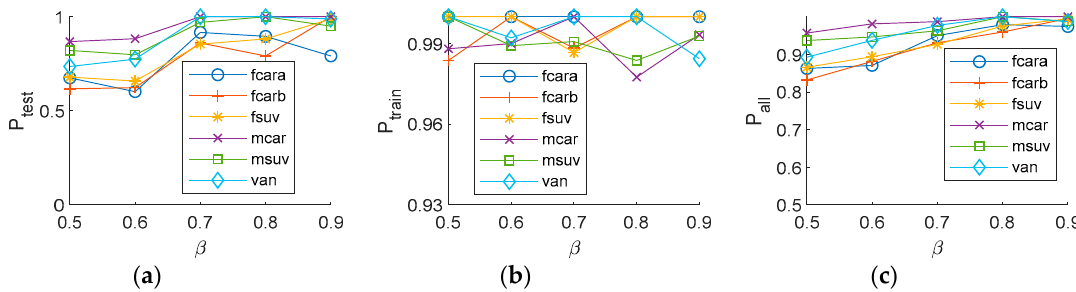
( c ) Figure 8. The curve of accuracy changing with training set ratio β when CNN takes different number of hidden nodes. The horizontal axis in the figure represents the proportion of the number of training images to the total number of images. The vertical axis represents the recognition accuracy: ( a ) The accuracy of the test set; ( b ) The accuracy of the training set; ( c ) The accuracy of all images. Figure 9 shows the curve of accuracy changing with the number of hidden nodes in CNN at different β . As can be seen from the figure, when the number of hidden nodes exceeds 100, the accuracy is generally stable, and does not increase significantly as the number of nodes increases. When the number of hidden nodes is greater than 100, the test accuracy test P ( b ) ( c ) Figure 9. The curve of accuracy changing with the number of hidden nodes in CNN at different β . The horizontal axis in the figure represents the hidden nodes in CNN. The vertical axis represents the recognition accuracy: ( a ) The accuracy of the test set; ( b ) The accuracy of the training set; ( c ) The accuracy of all images. Figures 10 and 11 show the recognition accuracy curves of each model of vehicle. Figure 10